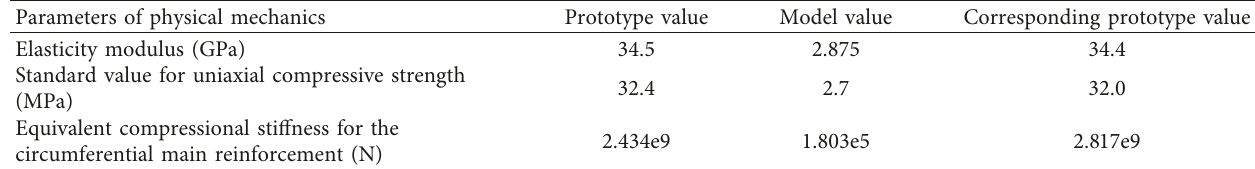
Table 4: Physical and mechanical parameters of segment